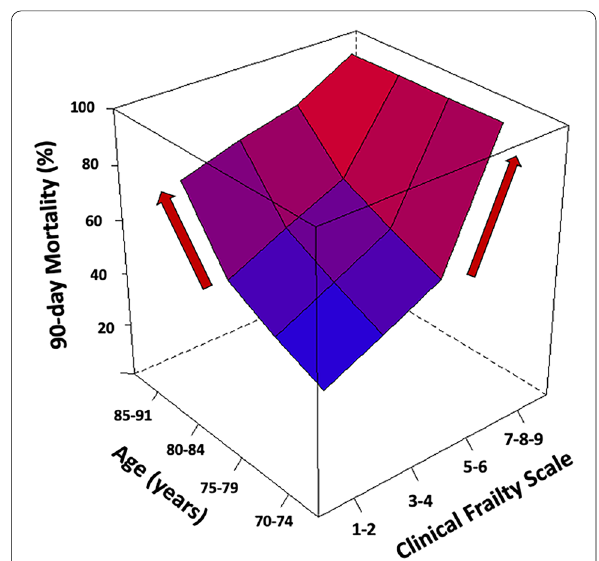
Fig. 1 Day-90 mortality according to age and Clinical Frailty Scale